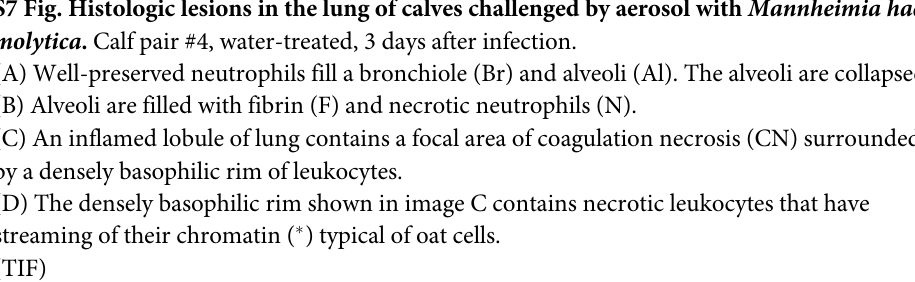
S8 Fig. Semi-quantitative scoring of histologic lung lesions in calves challenged with M. haemolytica . Grossly visible lesions were selectively sampled in three regions of lung: cranio- ventral, caudodorsal and caudoventral. Histologic lesions were semi-quantitatively scored based on bronchopneumonia (0–3), oat cells (0 or 2), and foci of coagulation necrosis (0–2).